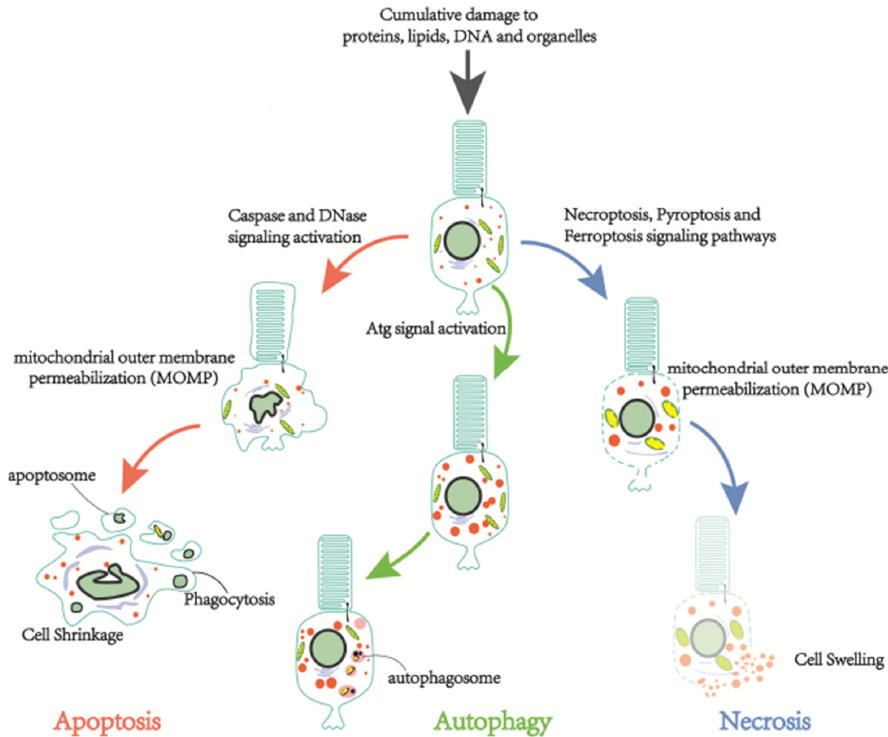
Figure 2. Three common types of cell death in RP. Damage signals from intracellular macromolecules cause necrosis, apoptosis, and autophagy, respectively.